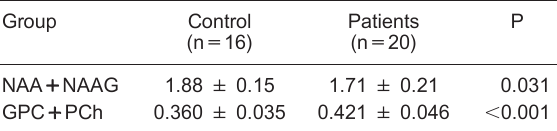
Table 4. Metabolite concentrations relative to the Cr++PCr concentration for the reduced groups (16 control subjects and 20 Huntington’s disease patients) with higher quality